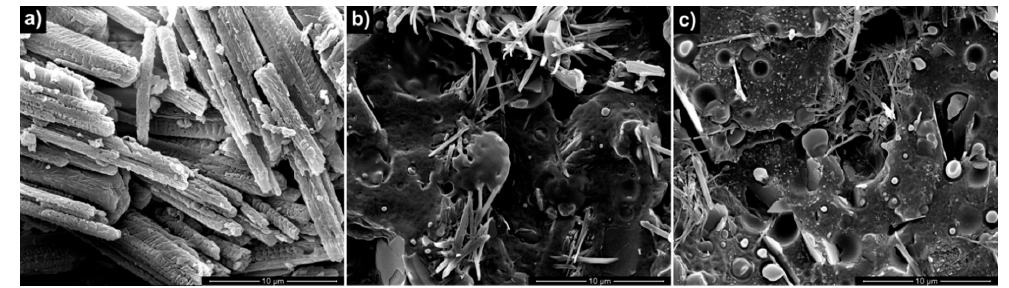
Figure 3. SEM micrographs of: ( a ) neat CFX; ( b ) BIO/CFX; ( c ) BIO/GnP-5/CFX.